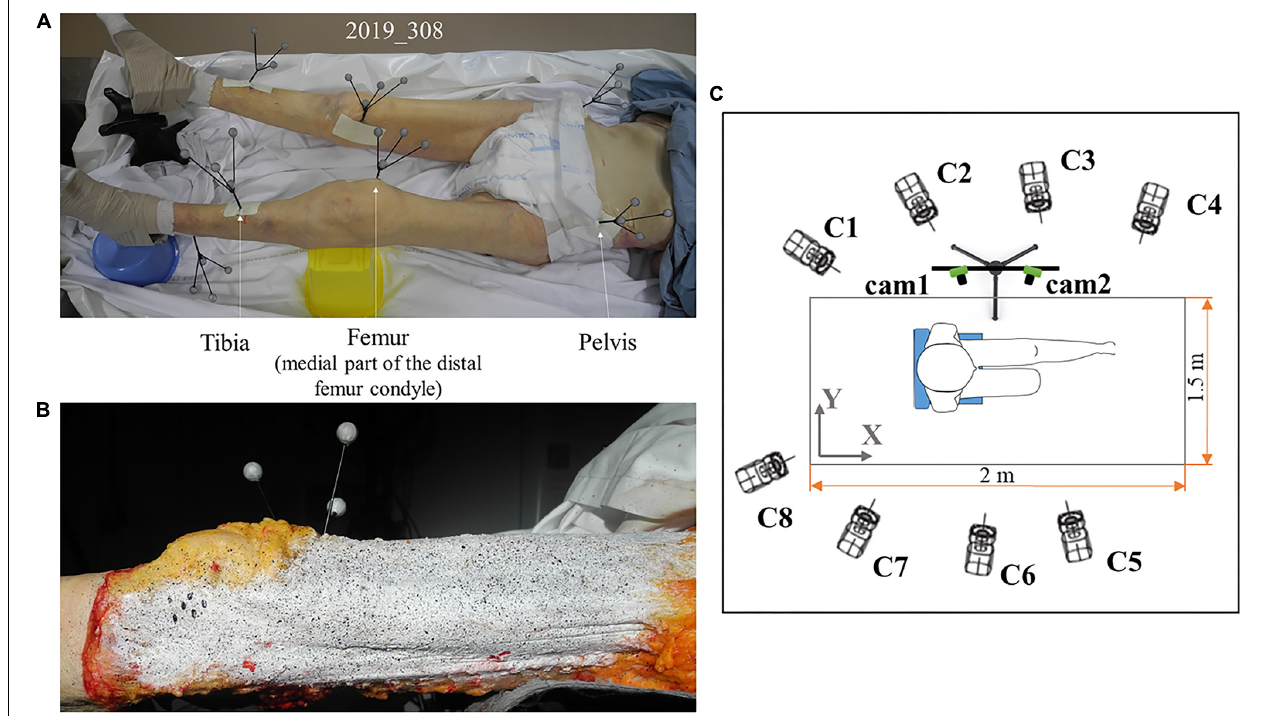
FIGURE 1 | Subject preparation and testing area: (A) tripods of markers for optical motion capture are screwed to the tibia, femur, and pelvis. These tripods allow for the analysis of leg movement and knee angles. To avoid contact between tripods of the right leg and those of the left leg, the left knee is elevated supported by the yellow box underneath it; (B) speckle pattern on fascia lata for stereo digital image correlation. White mask is applied to standardize the background and for good contrast of the speckle pattern created with black ink. (C) Motion capture and digital image correlation camera positions. Eight cameras (C1 to C8) for motion capture are placed around the chair where the subject is positioned. Camera positions are optimized so each tripod of markers can be seen by at least three cameras. Acquisition volume is 2 × 1.5 × 2 m 3 . Two cameras (cam1, cam2) for digital image correlation are placed perpendicular to the left leg of the subject and focused on it to acquire images of the speckle on lateral fascia and ITT during leg movement. These cameras can be moved to focus on the top of the leg to acquire strain field on anterior fascia.